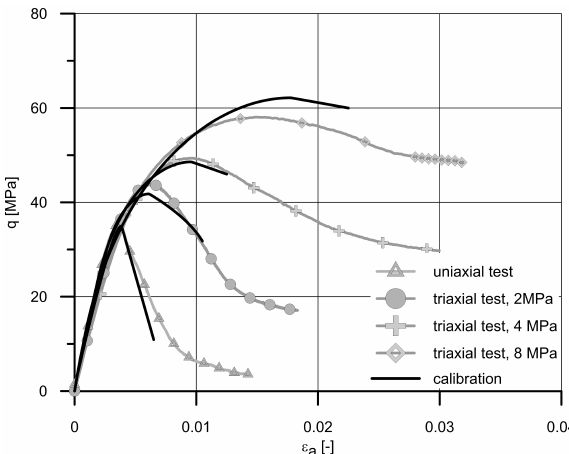
Figure 4. Measured and predicted stress – strain curves for profile CS-1.